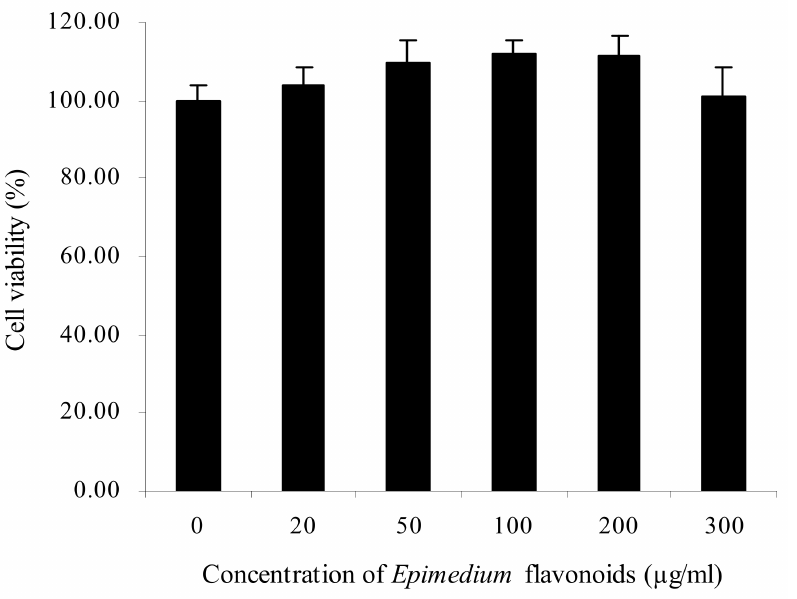
Figure 1. Cytotoxicity of Epimedium flavonoids on RA-treated SH-SY5Y cells. Data were expressed as means of five replicates ( n = 5).